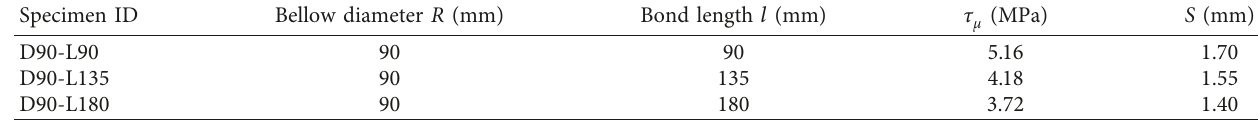
Table 2: Peak values of bond stress and the corresponding slips of different bond lengths.